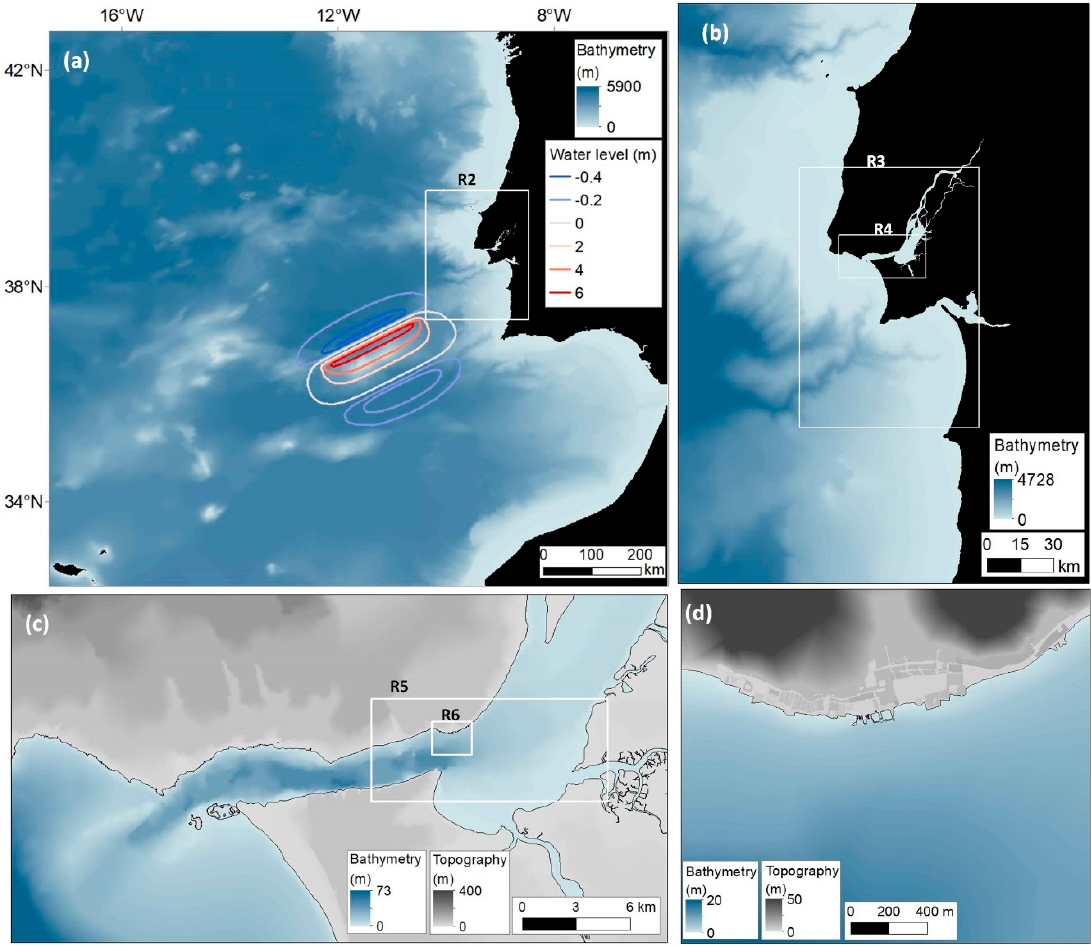
Figure 8. Conditions of the numerical model setting to downtown Lisbon: ( a ) region 1 and the initial sea surface displacement; ( b ) region 2 and the placement of regions 3 and 4; ( c ) details of region 4 and the placement of regions 5 and 6; ( d ) details of region 6.